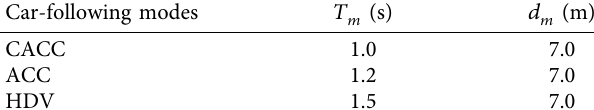
Table 1: The parameters setting of different car-following modes. Car-following modes